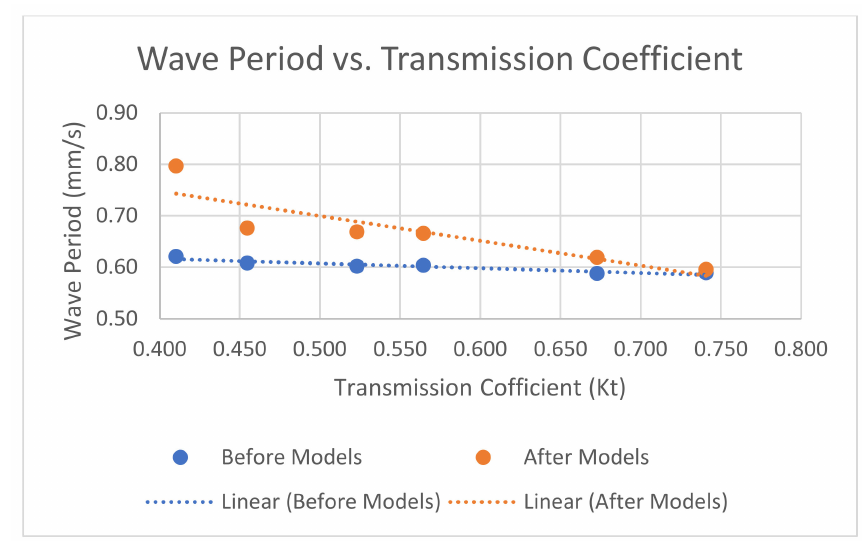
Figure 8. Variation of the wave period with the transmission